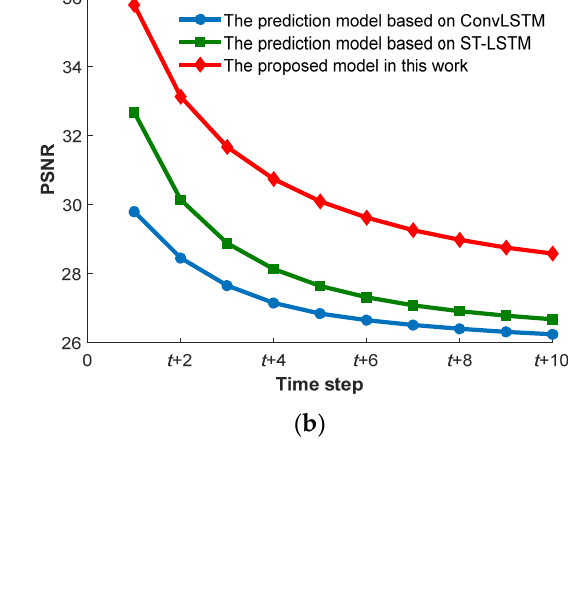
Figure 7. Average evaluation results of MSE ( a ), PSNR ( b ), and SSIM ( c ) at each time step where the time interval between two steps was set as 30 min, 1 h, 2 h, 6 h, and 12 h. Under the optimal setting, the performance of the proposed prediction model and the existing models are shown in Figure 8. The mean of PSNR values of the proposed prediction model was 30.67. The SSIM values of the proposed prediction model surpassed 85% for all time steps, which was higher than the ones of the prediction model based only on ConvLSTM and the prediction model based only on ST-LSTM. The mean of MSE val- ues of the proposed prediction model was 46.11 and the MSE values of the proposed pre- diction model were below 68 for all time steps. The proposed prediction model was not good at the MSE. The MSE values of the proposed prediction model at each step (from t + 4 to t + 10) were higher than the ones of the prediction model based only on ConvLSTM and the prediction model based only on ST-LSTM. As shown in Figure 5c, the projection area of wheat was as high as 1000 and the projection area was also the pixel number of the binary images. The relative difference of MSE between the proposed prediction model and the existing models was less than 30, which was acceptable. The results above vali- dated the proposed prediction model and showed its robustness as compared with the existing models. Figure 8. Cont